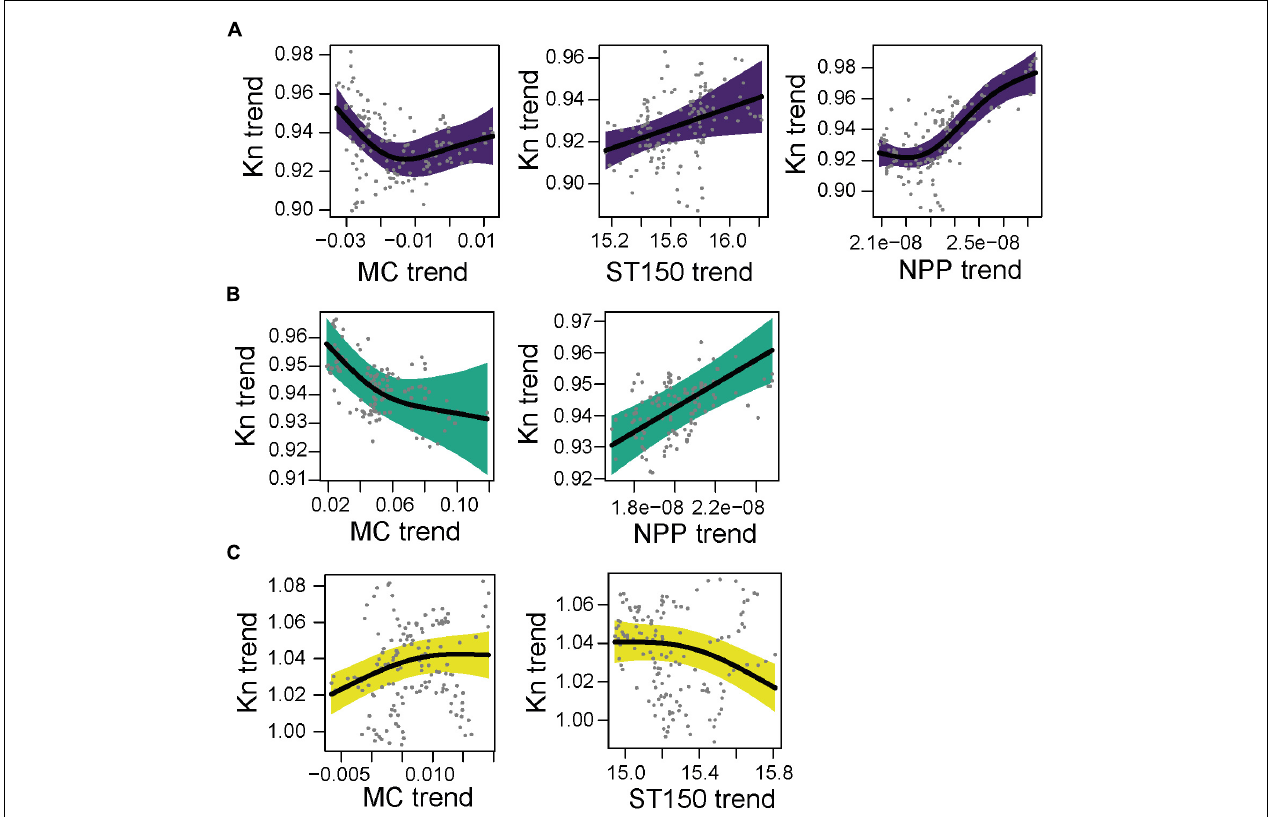
FIGURE 7 | Partial GAM plots for body condition index (Kn) of sardine ( Sardina pilchardus ) for each area; (A) North (purple), (B) Central (green), and (C) South (yellow). Significant partial effects of meridional current (MC), zonal currents (ZC), average sea temperature of 150 m (ST150) and net primary production (NPP), are represented. The shaded areas indicate the 95% confidence